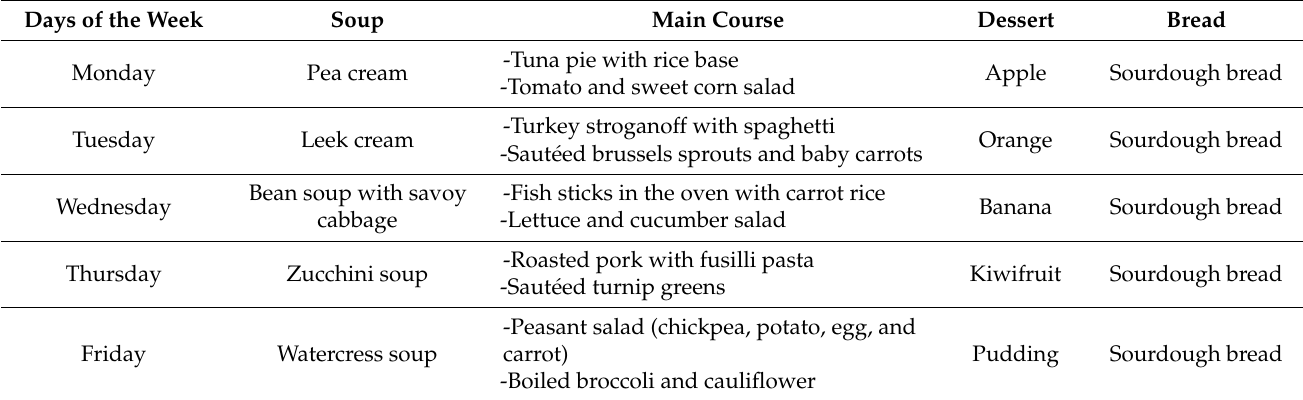
Table A2. Differed menu of one